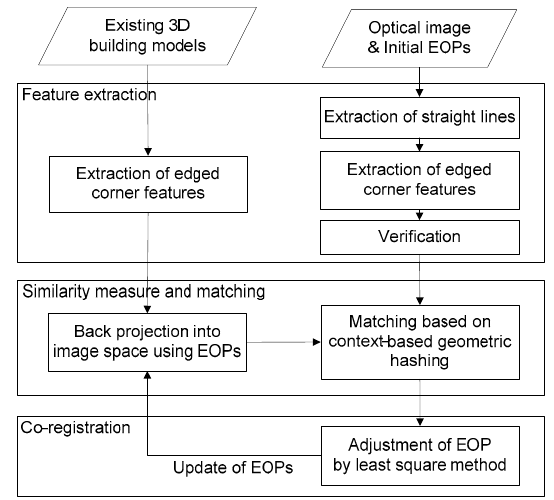
Figure 1. Flowchart of the proposed model-to-image registration method.